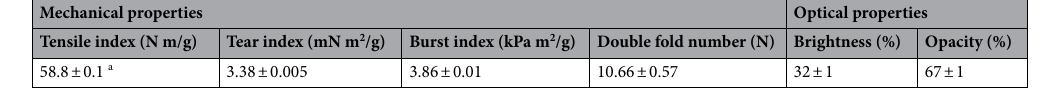
Table 2. Mechanical and physical properties of the produced papersheet from M. oleifera SRRP pulp. a Values are presented as mean± SD. SD Standard